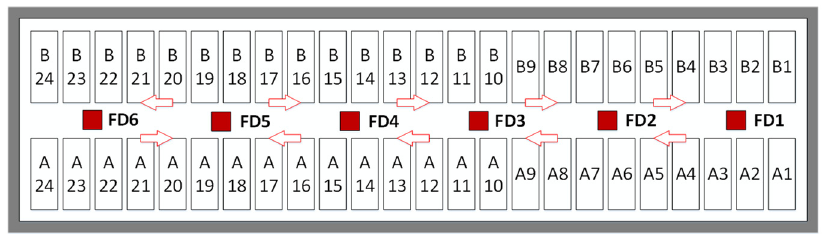
Figure 1. Top view of 400 kA large aluminum reduction cell.